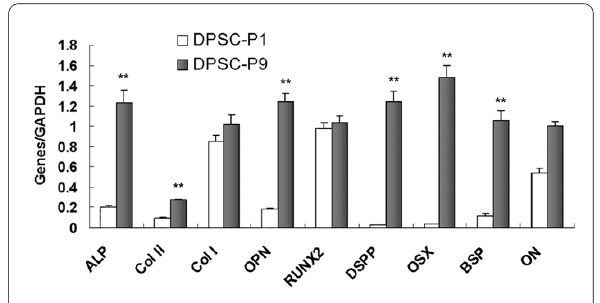
Figure 2 Gene expression of DPSCs at different passages by real- time reverse transcriptase-polymerase chain reaction . GAPDH was used as an internal control. Values are mean ± s.d., n = 6 (** P < 0.001).